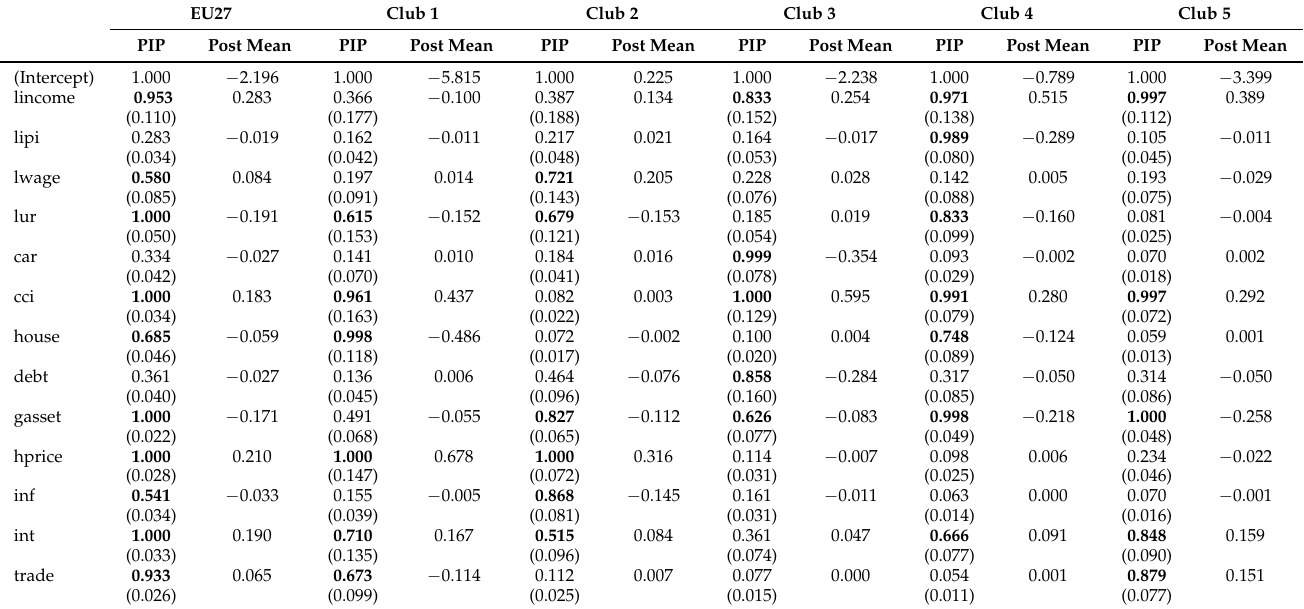
Figure 2. Model prior comparison—EU27. Table 4. BMA results with lagged income